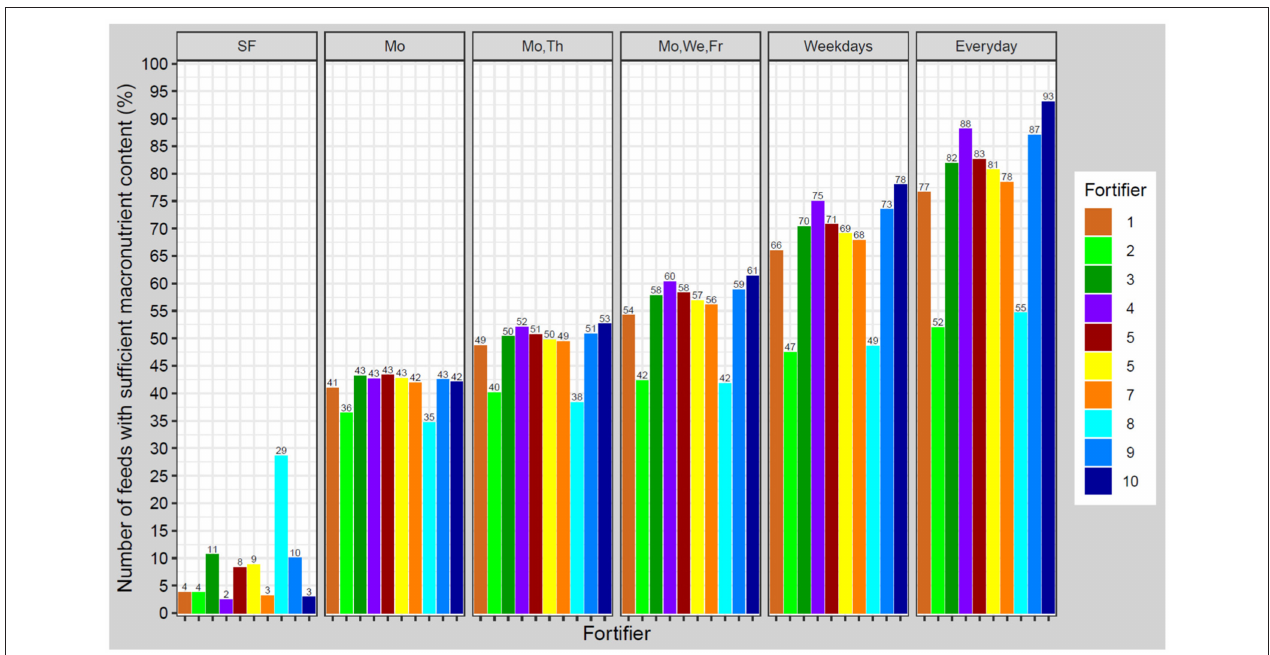
FIGURE 8 | Percentage of feeds with appropriate macronutrient content to achieve growth rates in a range of ± 1.0 g/kg/d from estimated target weight gain velocities. Ten different fortifiers in six different scenarios/schedules to measure breast milk macronutrient content were studied (SF, standard fortification; Mo,